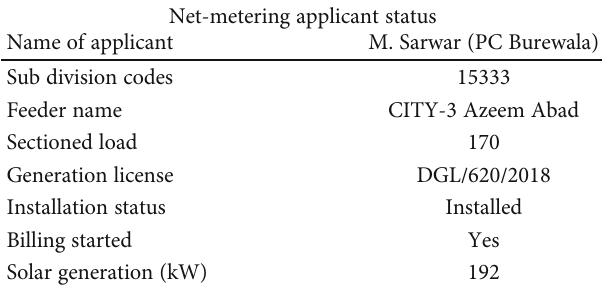
Table 3: Status of net-metering applicant, MEPCO